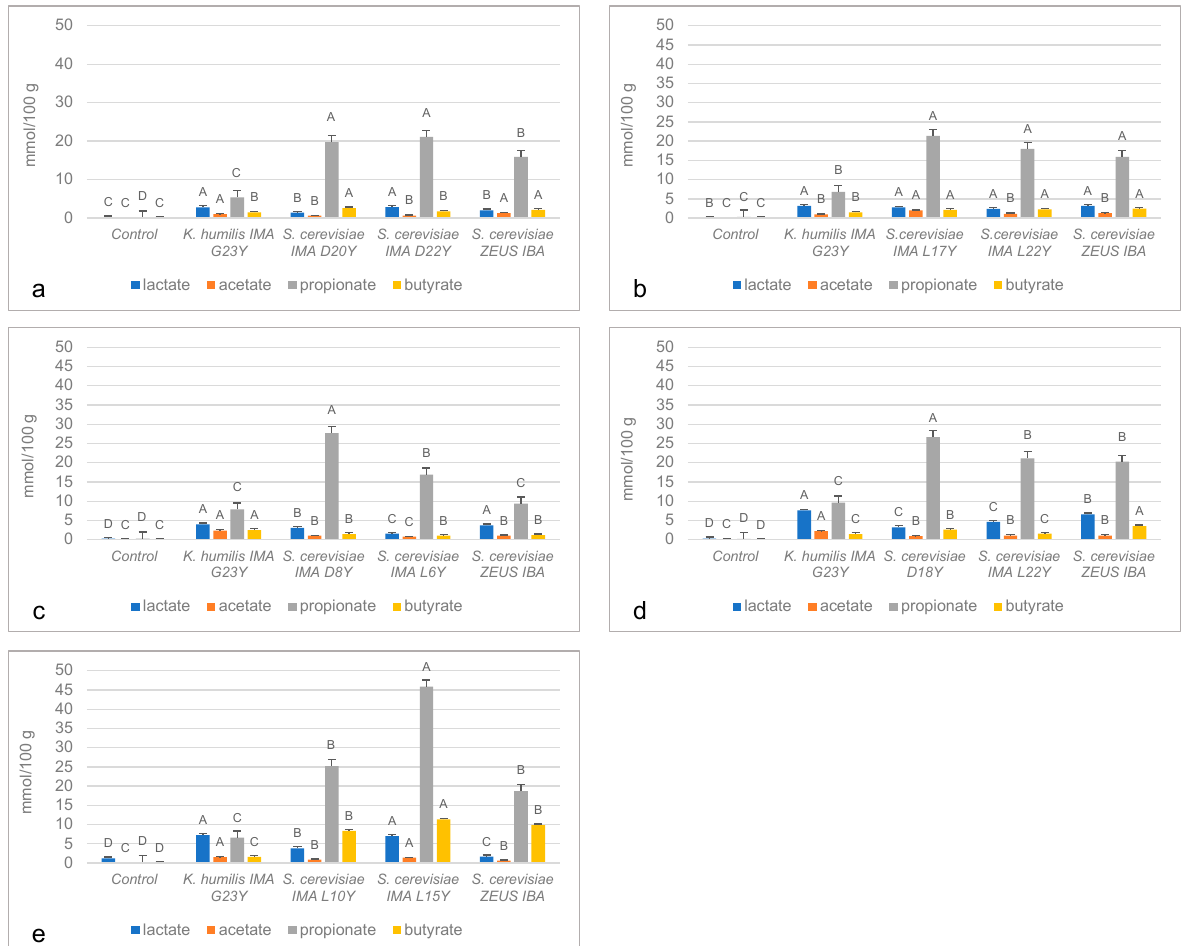
Figure 2. Histogram showing the organic acid profiles of fermented doughs individually inoculated with the yeast strains, obtained using ( a ) conventional red-grained wheat variety T. aestivum L. cv Aubusson, ( b ) yellow-grained wheat variety T. aestivum L. cv Bona Vita, ( c ) blue-grained wheat variety T. aestivum L. cv Skorpion, ( d ) winter emmer variety Triticum turgidum subsp. dicoccum var. Schrank , Giovanni Paolo and ( e ) hull-less spring barley variety Hordeum vulgare L. var. nudum Hook , Rondo. A–D: means within organic acid with different letters significantly differ ( p ≤ 0.01).